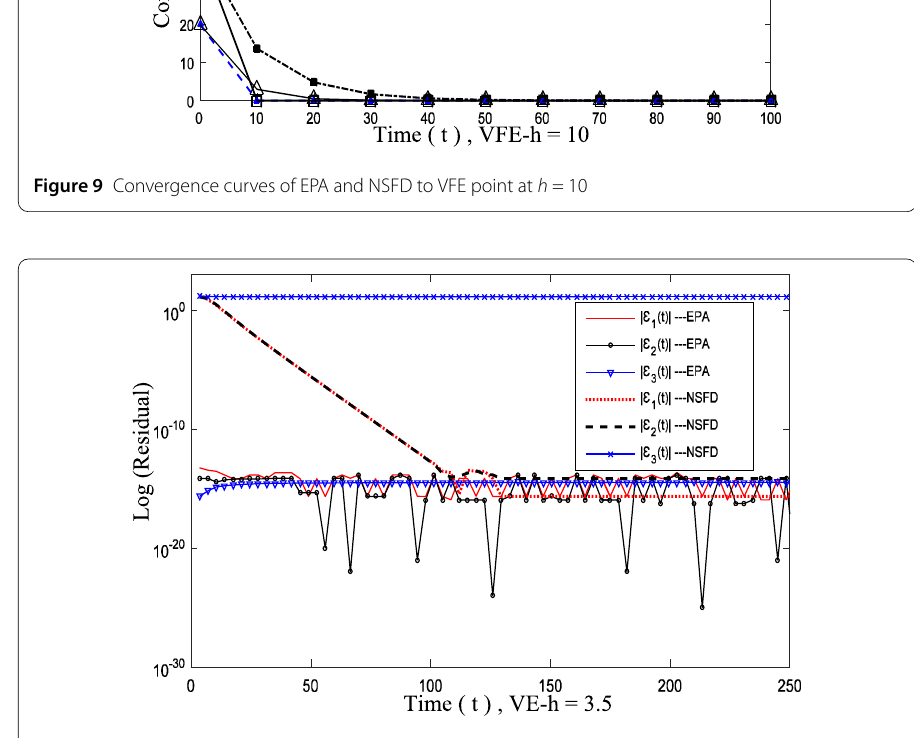
Figure 10 Absolute residuals of EPA and NSFD solutions for VE at h =